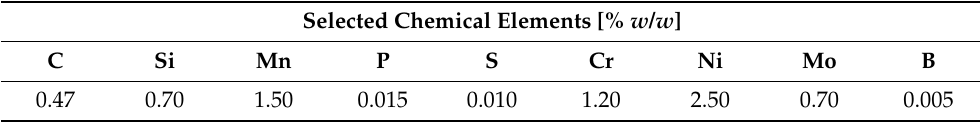
Table 2. The declared chemical composition of Hardox 600